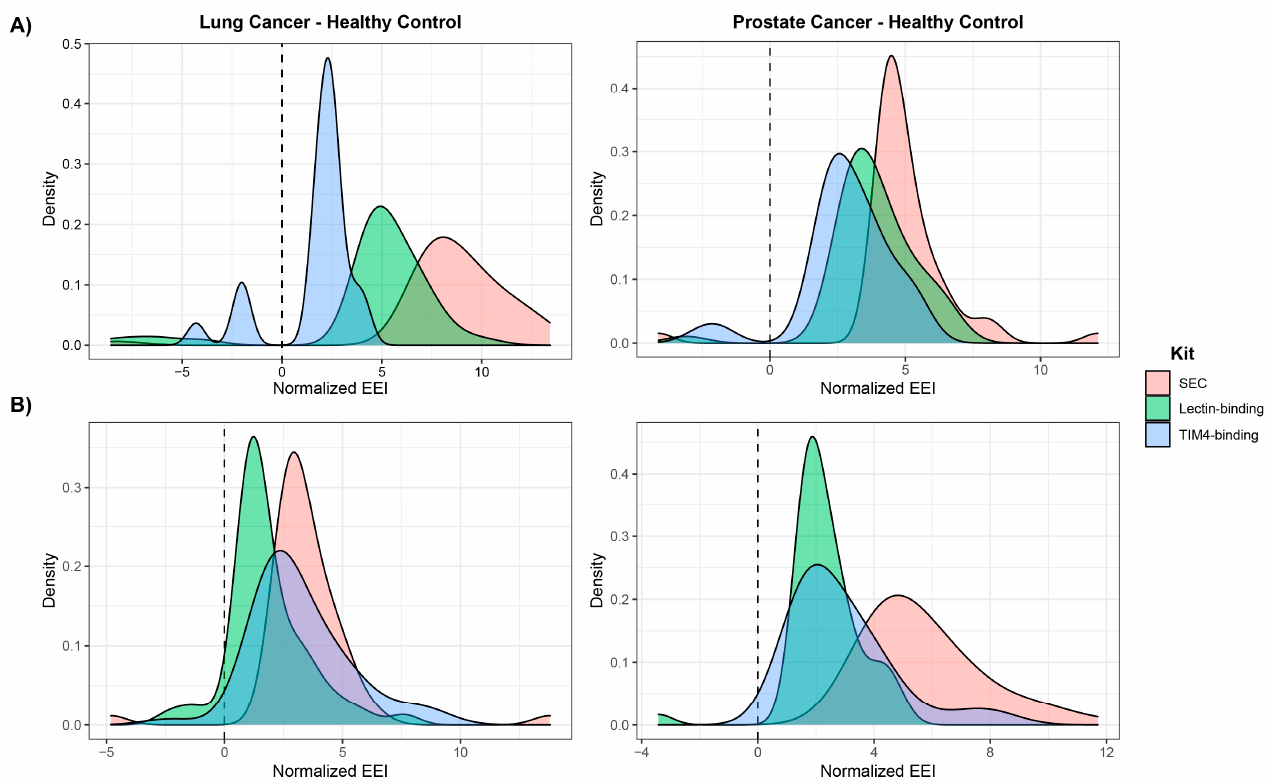
Figure 7. Exosome enrichment index (EEI) produced by the top 50 significant molecules of ( A ) lipids and ( B ) metabolites when comparing cancer samples to healthy controls. Size exclusion chromatography shows consistently higher EEI than the other two methods.